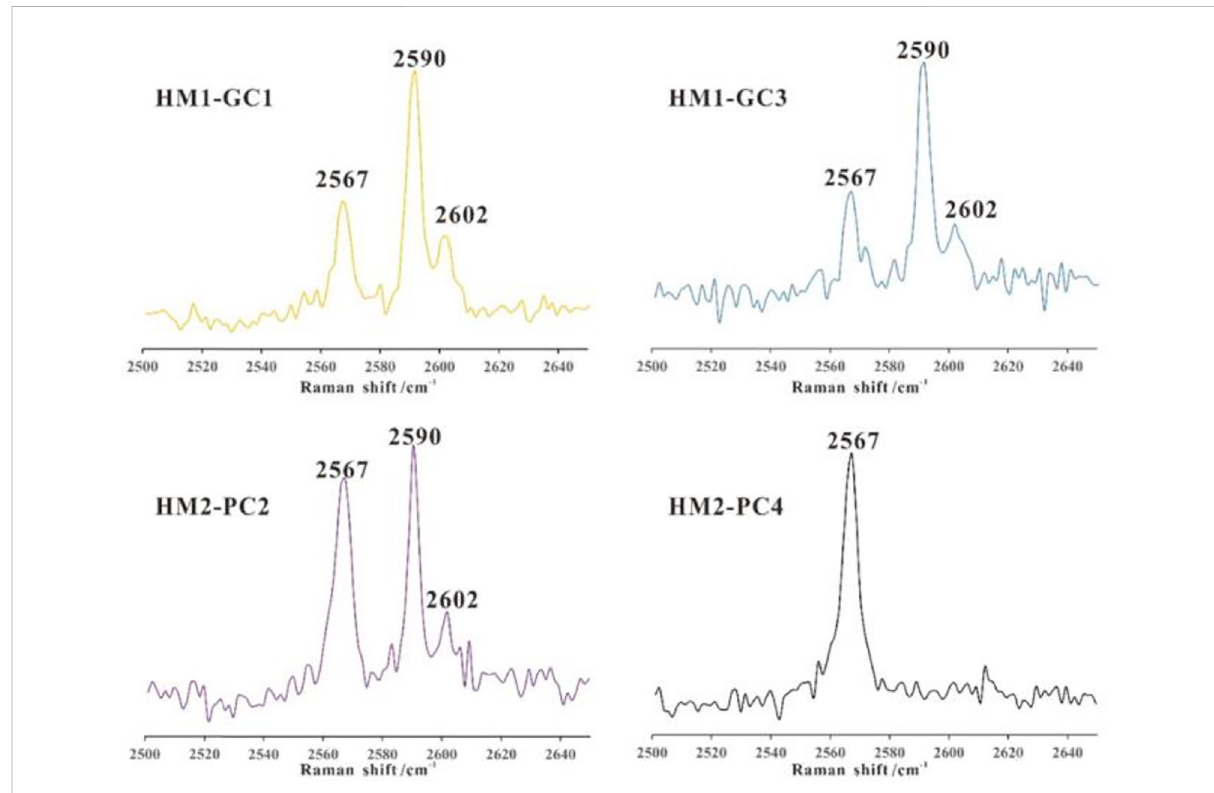
FIGURE 3 The concentration of H 2 S in gas hydrate at Qiongdongnan basin (Referend from huang et al.,